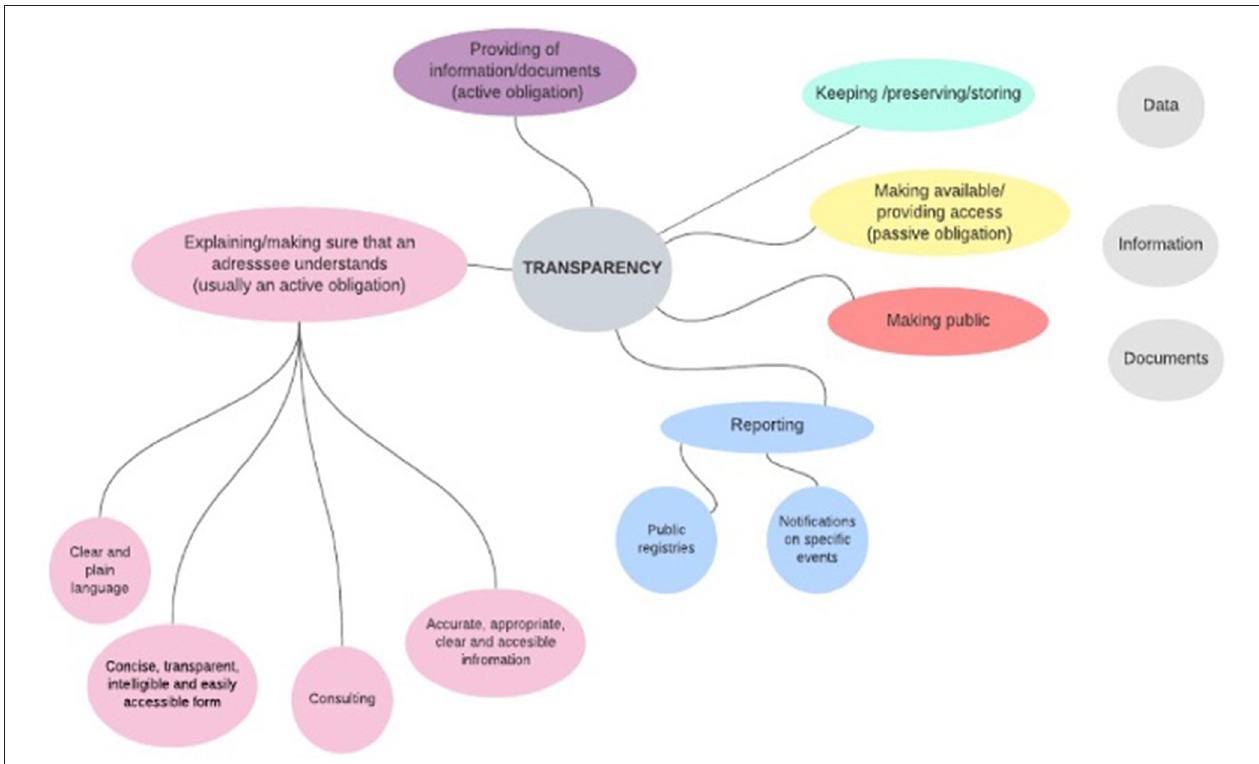
FIGURE 1 | Activities associated in the EU legislation (listed in Annex I ) with transparency